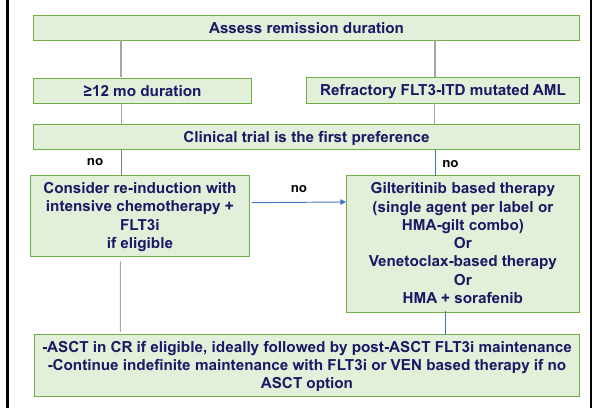
Fig. 4 Treatment algorithm of relapsed or refractory FLT3 mut AML. SCT stem cell